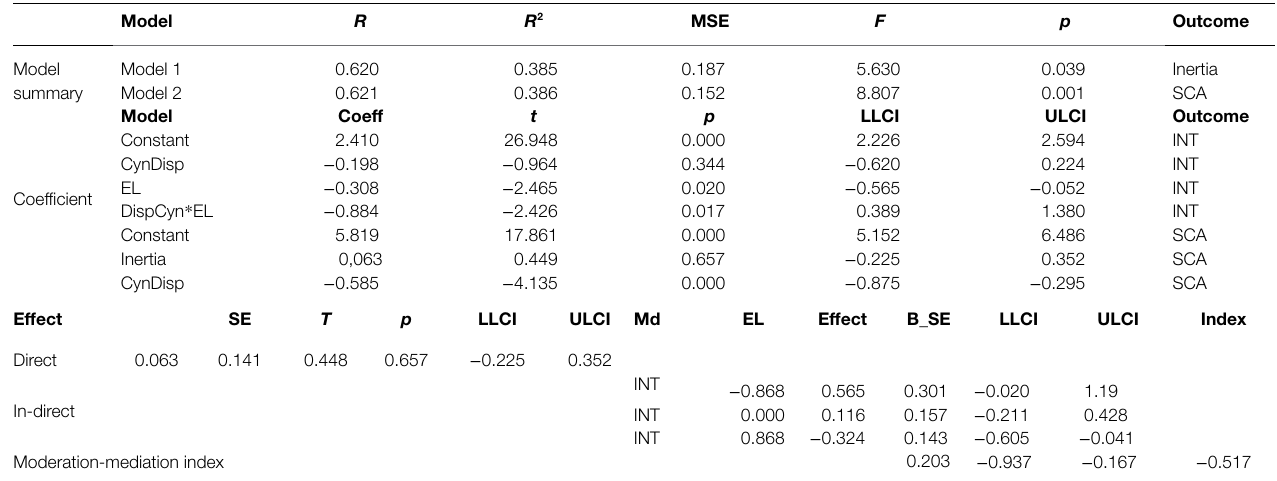
TABLE 3 | Model summary and coefficient (Hayes v3.5) Model 7.